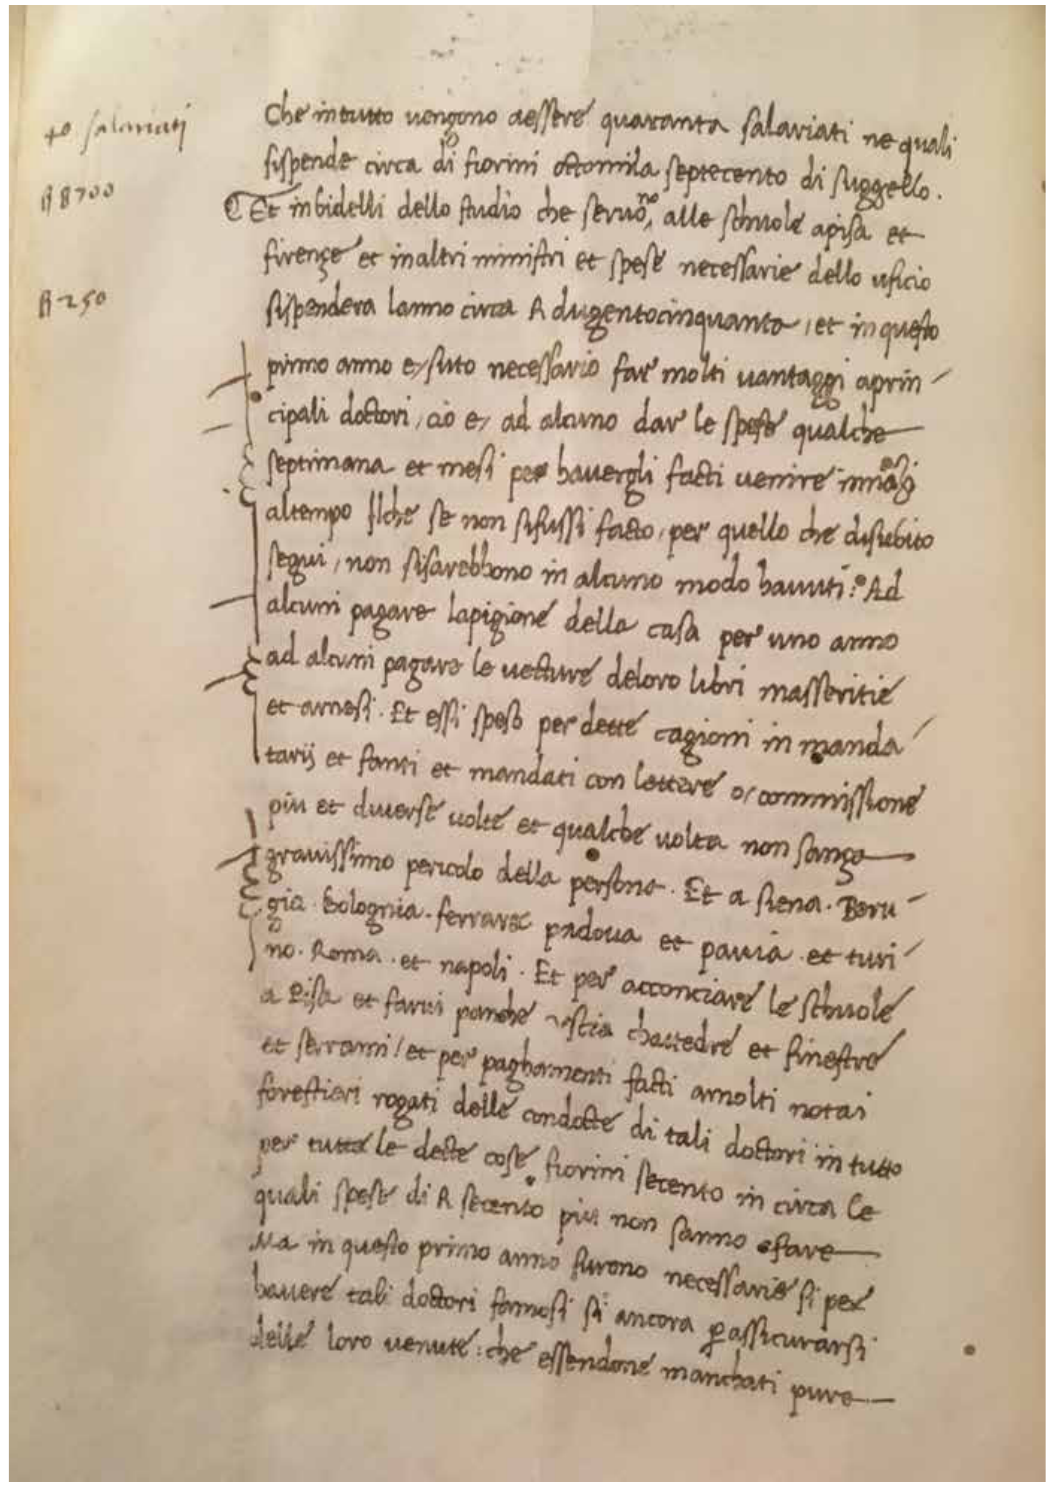
Fig. 2. BL, Add. MS. 8537, f.